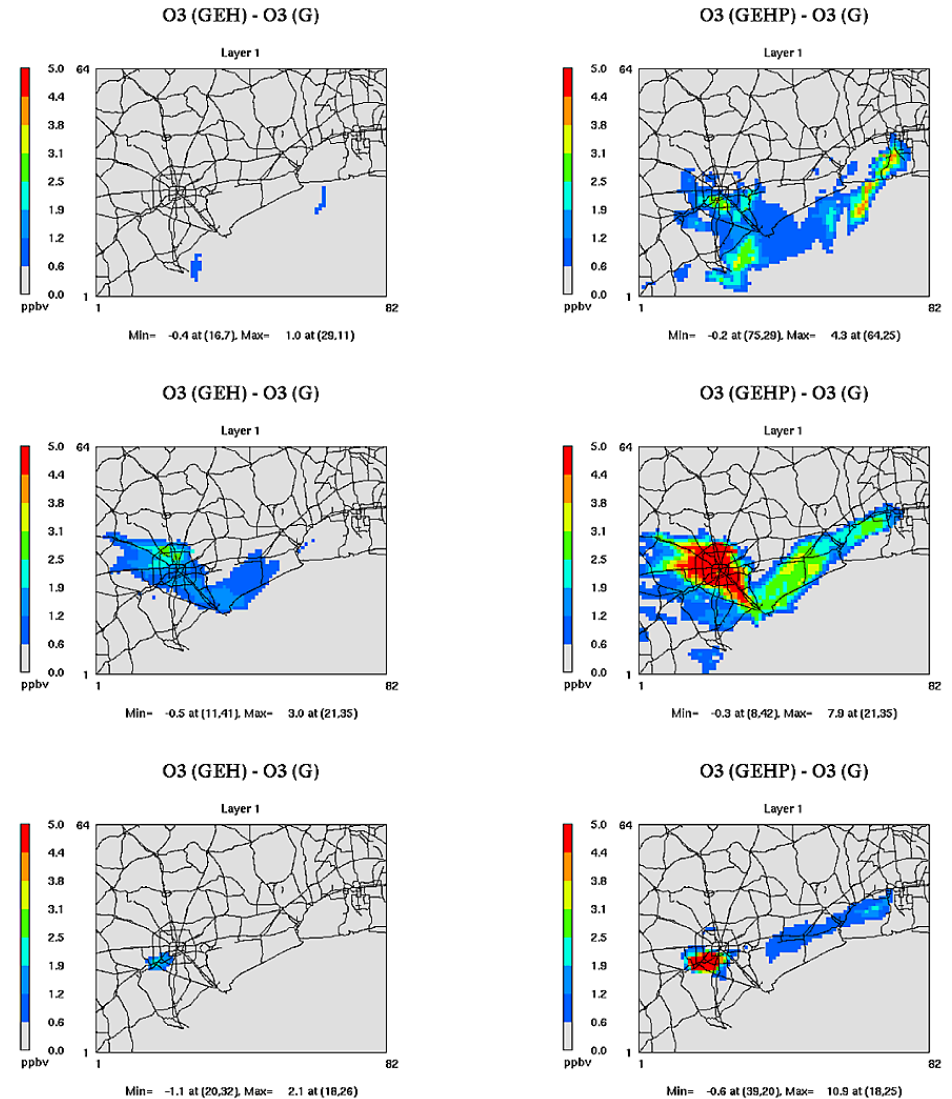
Fig. 8. Differences in surface ozone simulations between GEH-G case (left) and GEHP-G case (right) for 30 August at noon (top row), 31 August 2006 at 09:00a.m. CST (middle row) and 01:00p.m. CST (bottom